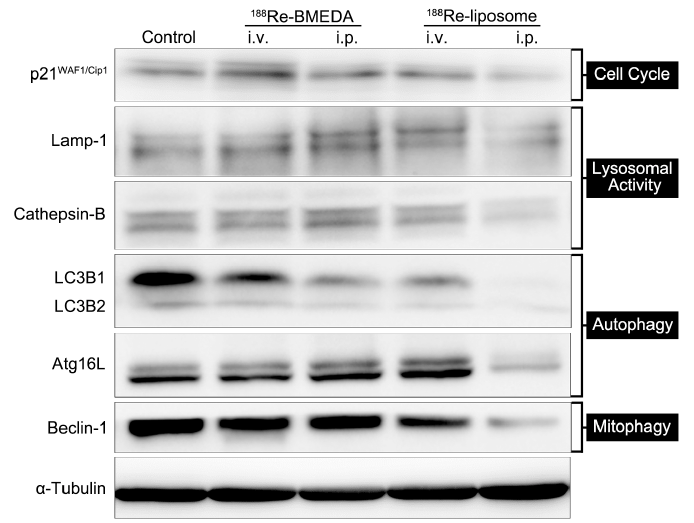
Figure 4. Intraperitoneal delivery of 188 Re-liposome downregulates proteins of the cell cycle, lysosomal activity, selective and non-selective autophagy. The expression of related proteins is shown by Western blotting analysis and presented subsidence of p21 WAF/Cip1 , Lamp-1, cathepsin-B, LC3B, Atg16L and Becline-1 upon 188 Re-liposome i.p. treatment. Representative data are shown from triplicate experiments. LC3B, microtubule-associated protein 1 light chain 3B; Atg16L, autophagy related 16-like gene.